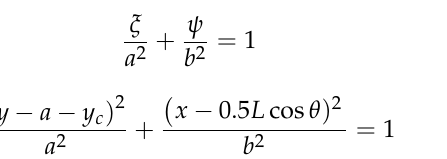
Figure 13. Multi-flexible fingers harvesting model of pineapple. The tangent line of the ellipse is expressed as Equation (15). The ellipse in the coor- dinate system is expressed as Equation (16).